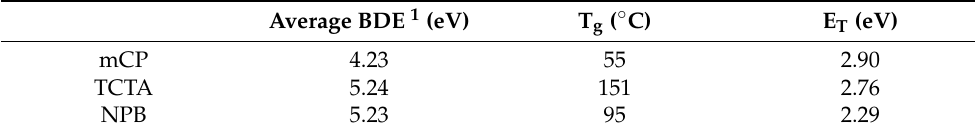
Table 4. Average BDE, T g , and E T for selected hole transport materials